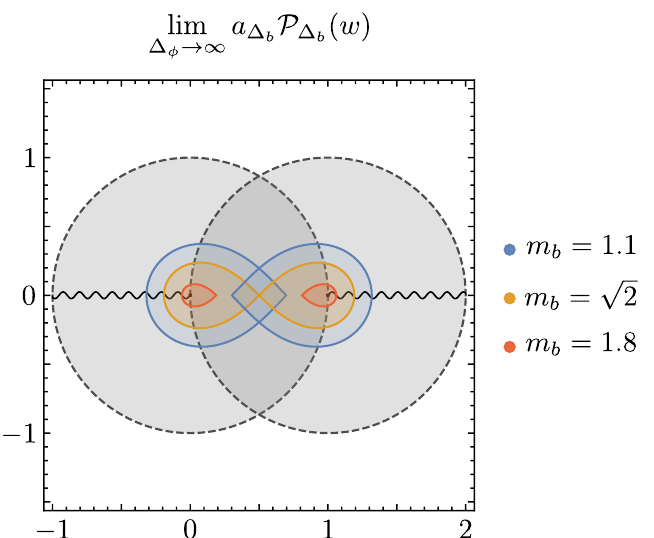
Figure 3 . Large ∆ φ limit of a single state below threshold ∆ b = m b ∆ φ < 2∆ φ . Each color represents different bound state masses. The limit is well defined for complex values of w outside the shaded regions and diverges inside. The divergent regions (and their crossing symmetric images) start at w = m 2 / 4 ( w = 1 − m 2 / 4 ) and always include a subset of the physical line w > 1 ( w < 0 ); √ b b they overlap whenever m 2 . These regions lie always inside the divergent region for the identity b < given by the two discs depicted in